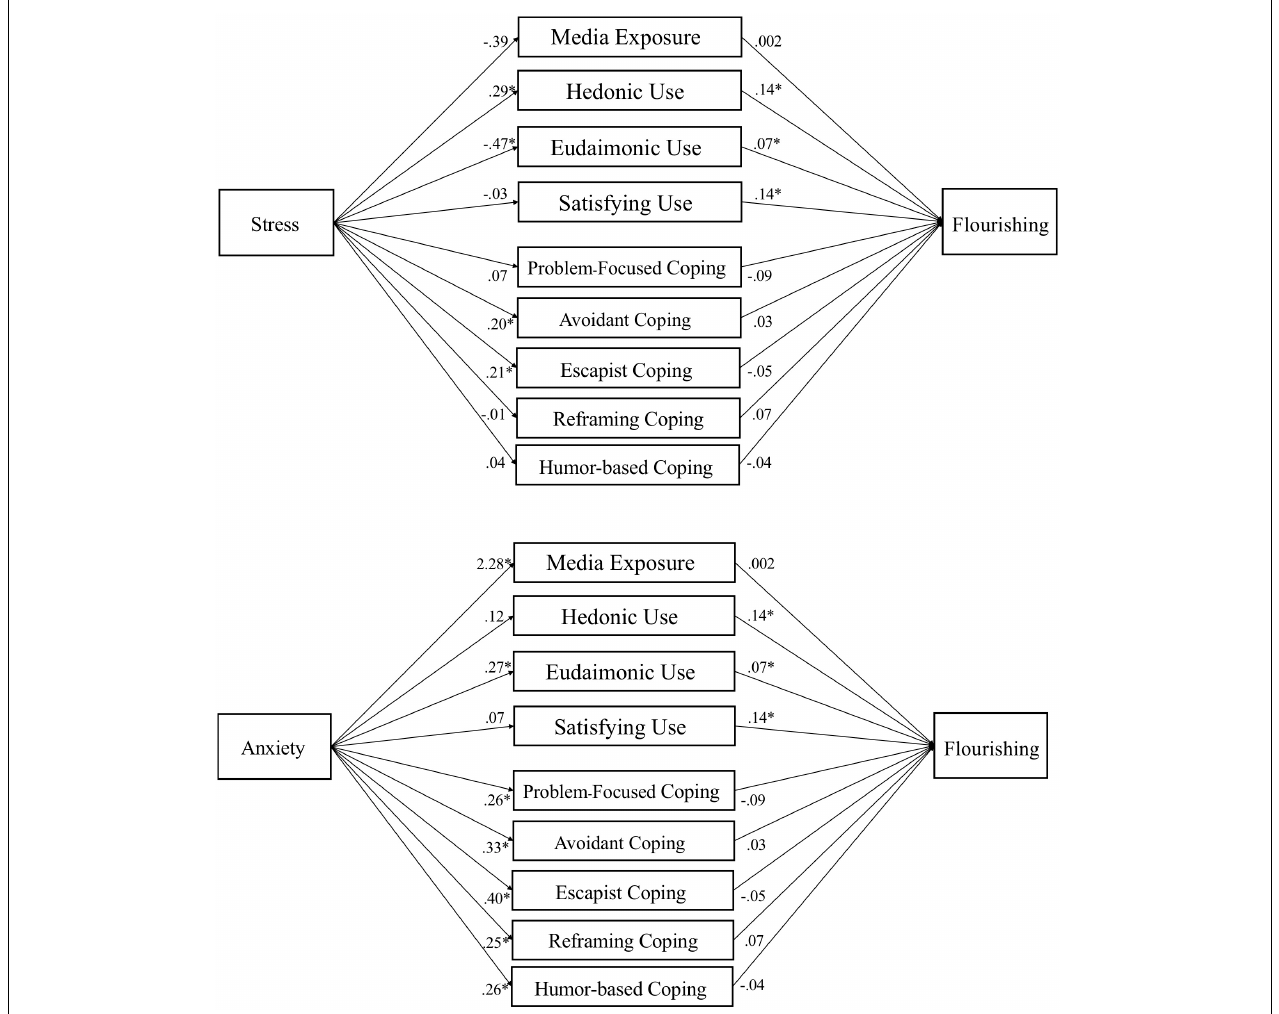
FIGURE 4 | Media use partially mediates influence of stress and anxiety on flourishing. Note. Parallel mediation of media motives on flourishing. Gender, age, ethnicity, race, level of education, and traits (hope, optimism, and resilience) are used as covariates in PROCESS Model 4 using 10,000 bootstrap samples. Path coefficients reported are unstandardized, p < .05 denoted with an *. Indirect effects appear in text and Table 7